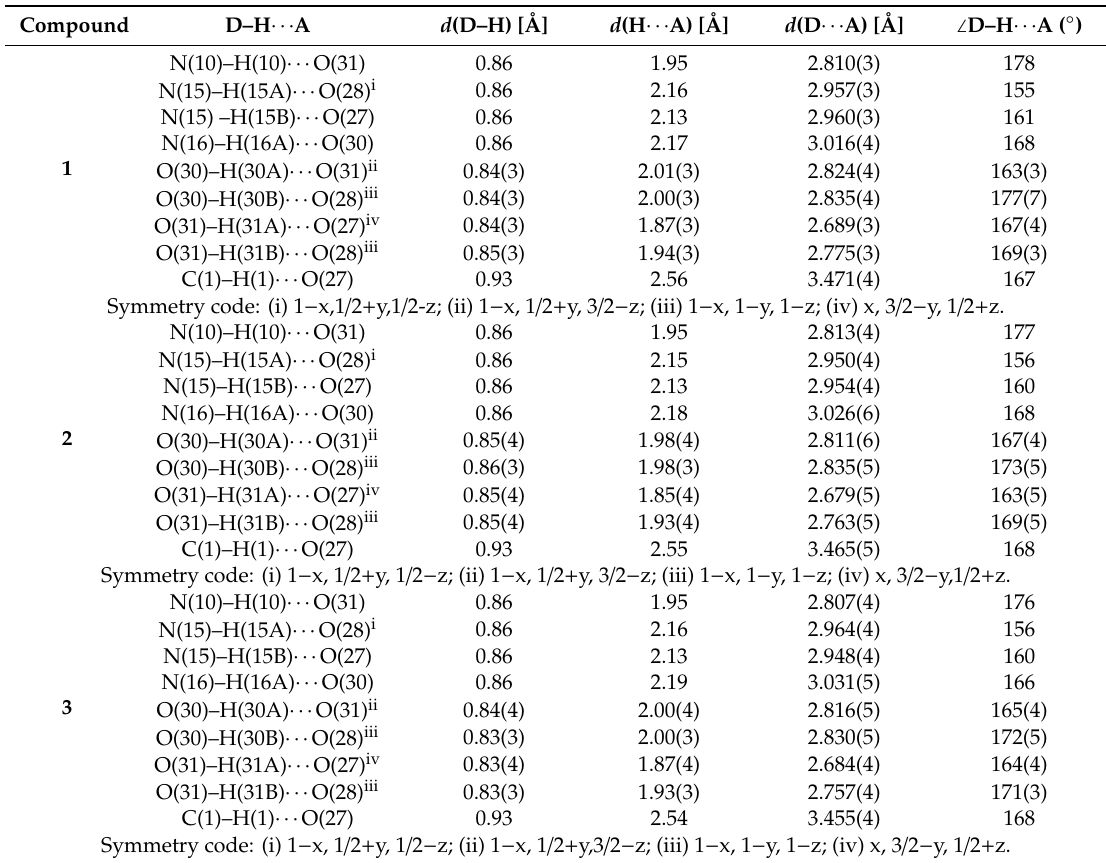
Table 2. Hydrogen bonds geometry for compounds 1 – 3.